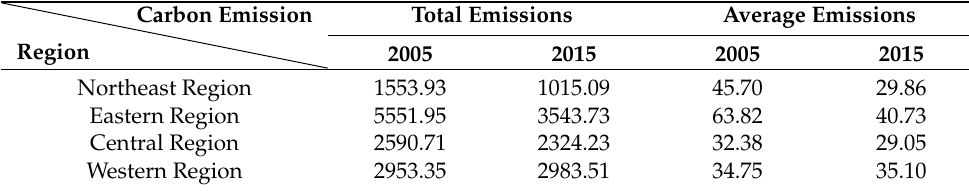
Table 1. Carbon emissions from urban households (Unit: 10 4 tons).